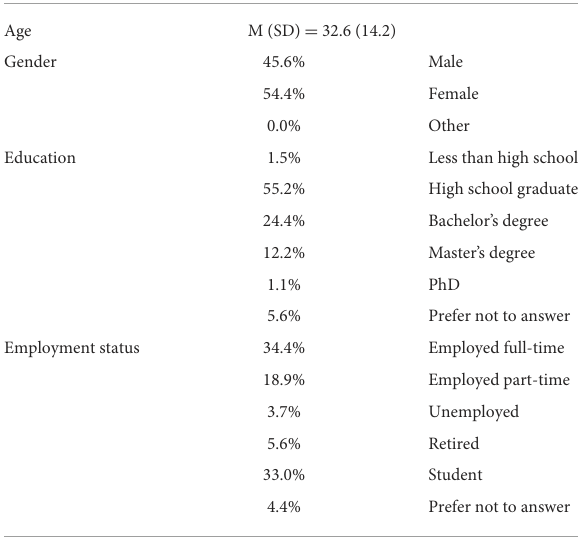
TABLE 1 Socio–demographic characteristics of total sample ( N =